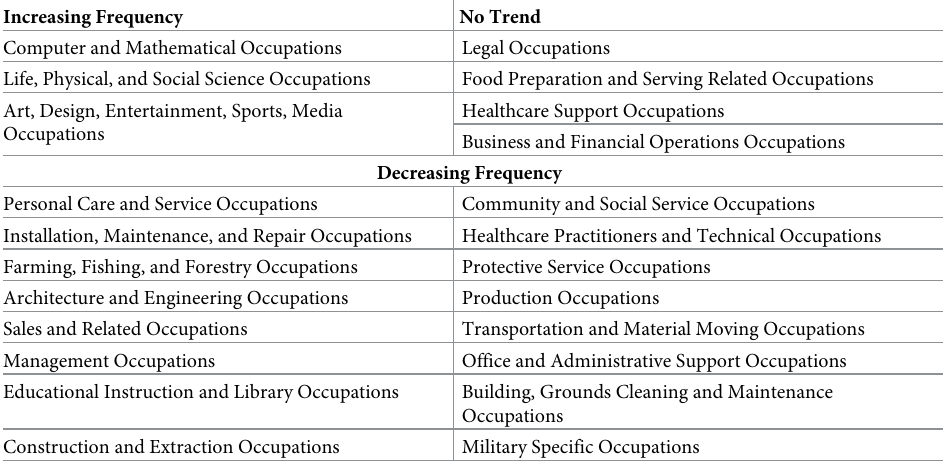
Table 3. SOC major groups with increasing, decreasing or no frequency trend over